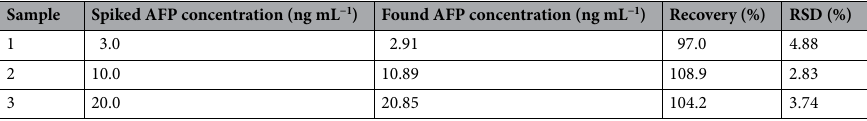
Table 2. Determination of AFP in human serum samples.